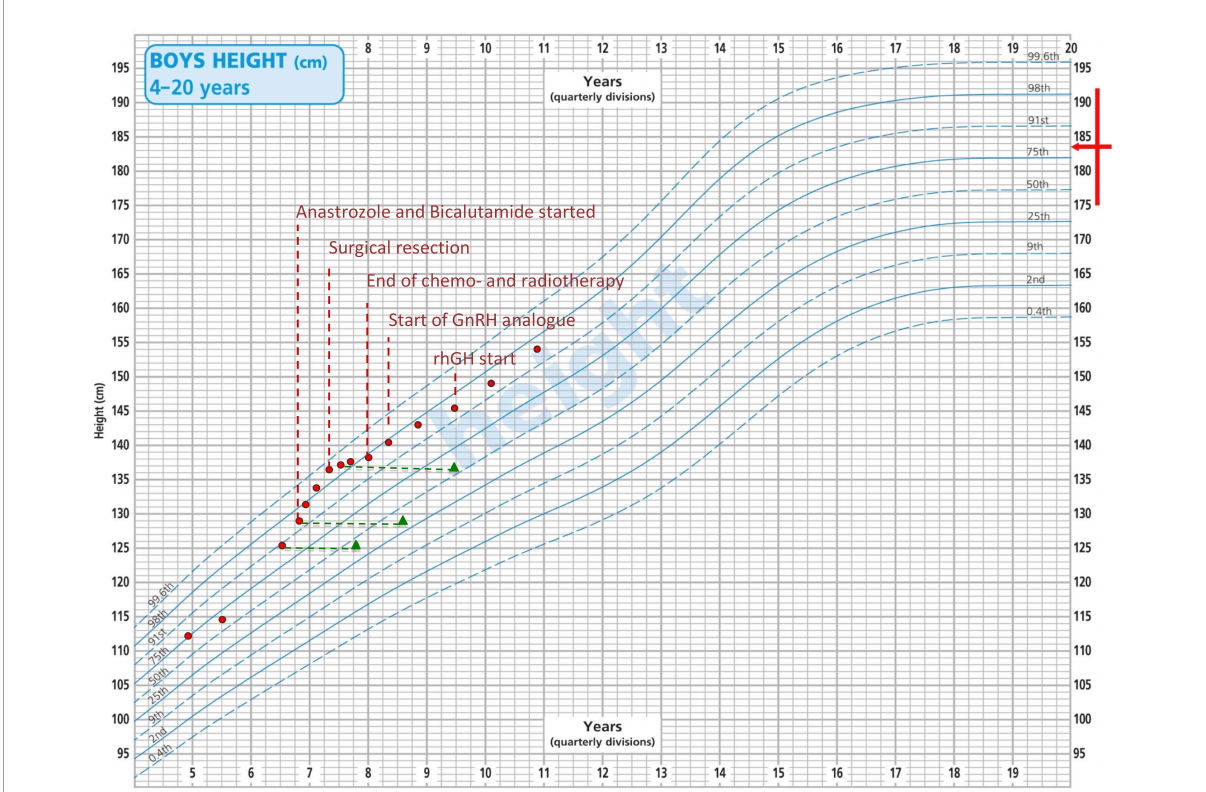
FIGURE2 Patient’s growth chart according to the CDC height centiles for reference population. Red dots represent the height recorded at each time point. Green triangles represent patient’s bone age. The red arrow indicates familiar height